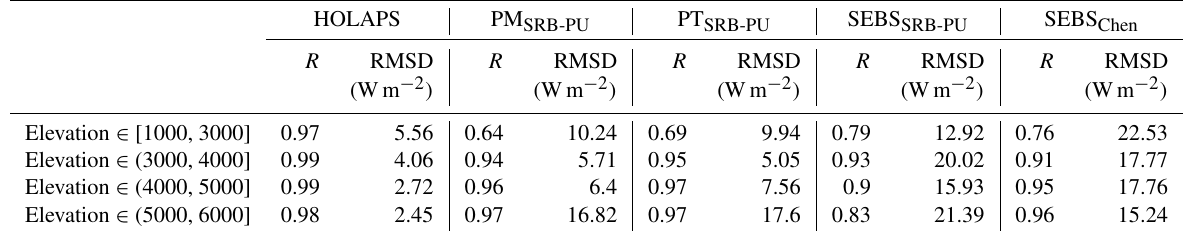
Table 6. Statistics of the LE comparisons between the LandFlux-EVAL benchmark product and other products over different elevation thresholds.